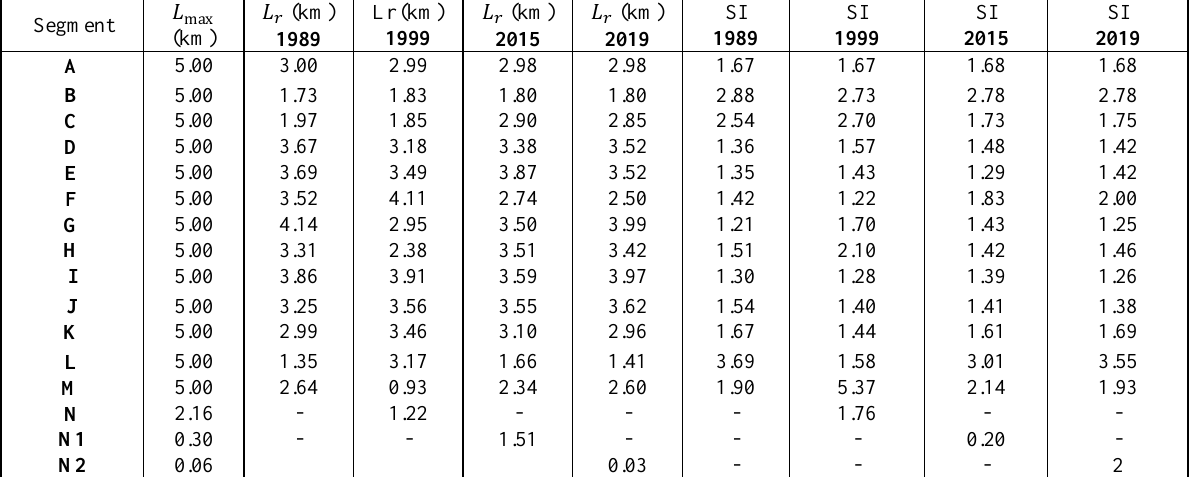
Table 2. Sinuosity Indices of the Zab River segments from different years of satellite